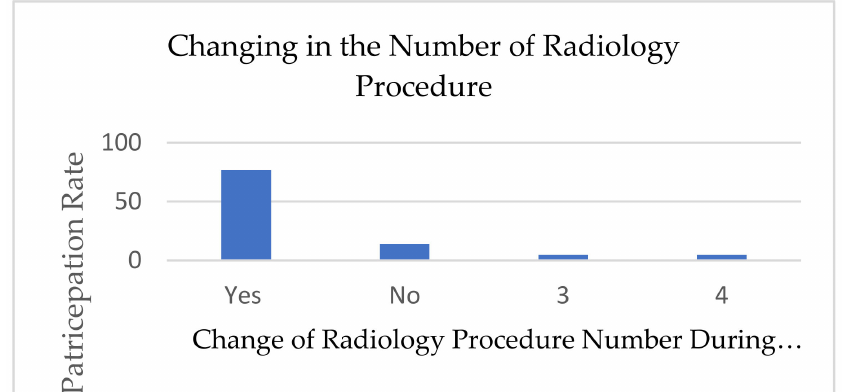
Figure 1. Change in radiology procedure within diagnostic radiography practice due to COVID-19.